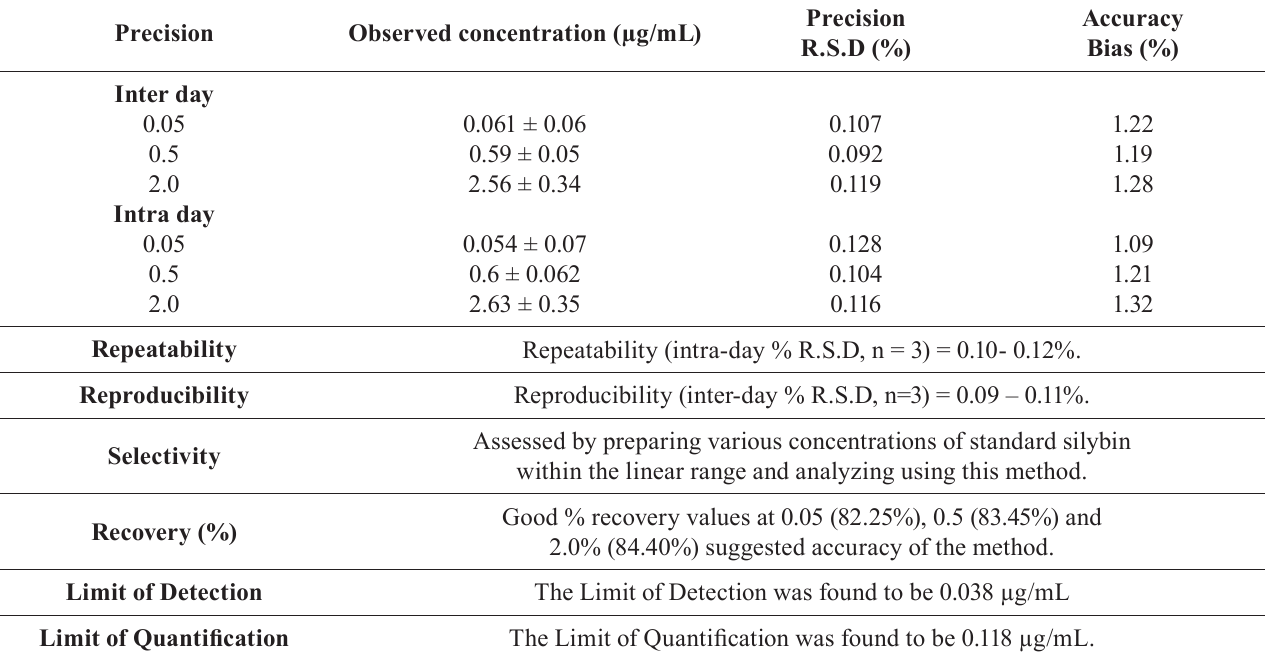
TABLE I - M ethod validation for the inter-day and intra-day assay precision (% R.S.D) and accuracy (% bias) of the HPLC method for the determination of silybin in plasma Precision Observed concentration (µg/mL)